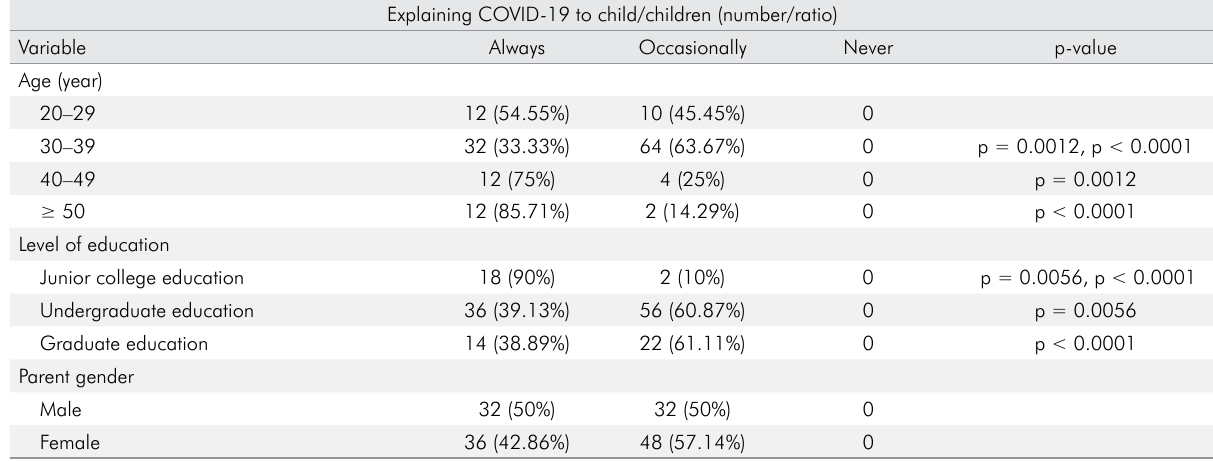
Table 2. Data on parents explaining COVID-19 to their child/children (by parent age, level of education and gender). Explaining COVID-19 to child/children (number/ratio)